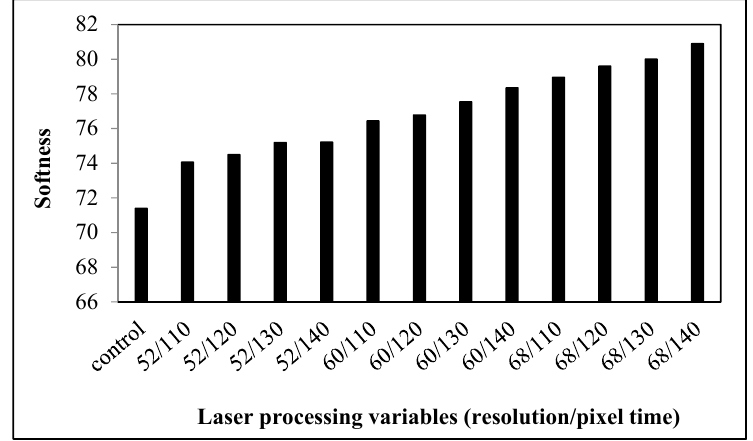
Figure 4. Relationship between laser processing variables and the softness of cotton fabric.